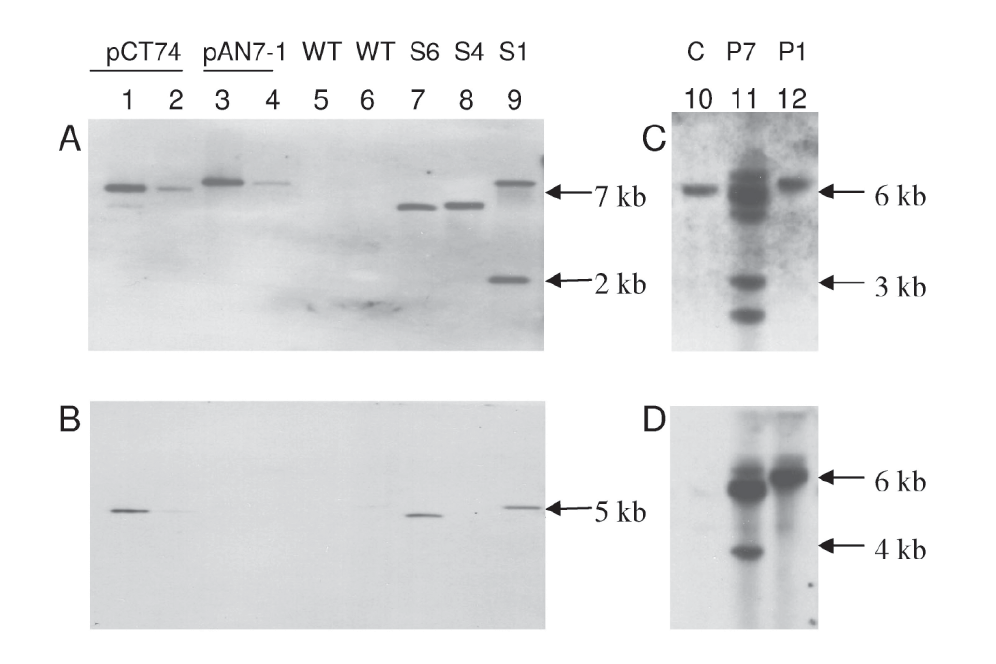
Fig. 3. Southern blot hybridised with DIG-labelled hygromycin B phosphotransferase ( hph ) (A, C) and green fluo- rescent protein ( gfp ) (B, D) gene fragments. Lanes 1–4, 100 pg (lanes 1, 3) or 10 pg (lanes 2, 4) of vector controls linearised with Cla I (pCT74) or Hin dIII (pAN7-1); lanes 5 and 6, genomic DNA from wild-type Eutypa lata E10-10 digested with Cla I and Hin dII respectively; lanes 7–9, genomic DNA from pCT74 E. lata transformants S1, S4 and S6 digested with Cla I; lane 10, genomic DNA from control (pAN7-1) transformant (C) of Phaeomoniella chlamy- dospora ; lanes 11–12, genomic DNA from pCT74 P. chlamydospora transformants P7 and P1 digested with Cla